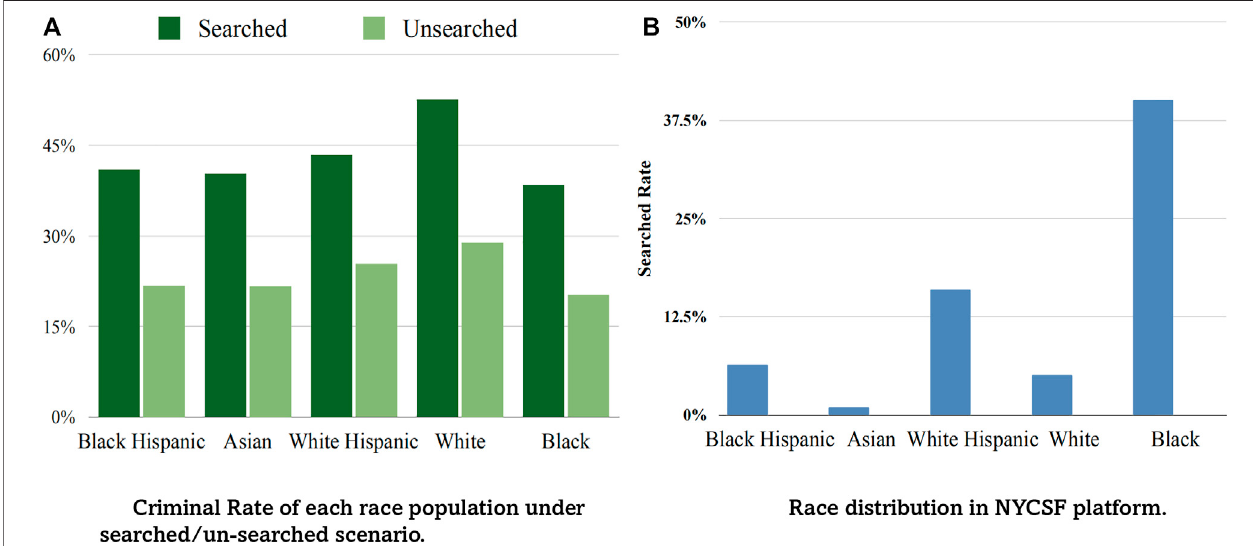
FIGURE 1 | Statistical analysis on NYCSF dataset. Figure (A) shows the black racial population has the lowest criminal rate than other race populations in both searched/un-searchedgroups.Figure (B) showstheblackisoverwhelminglysearched. Selectiveenforcementmakesmoreblackpeoplesearchedbypolicewhilemost of them are